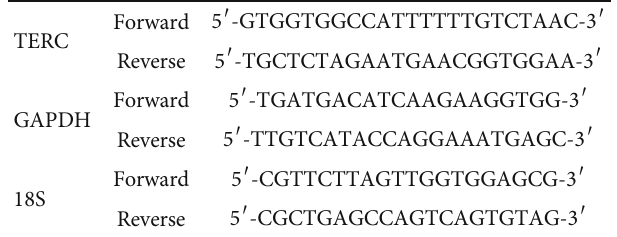
Table 1: Primer sequences are listed in the table.